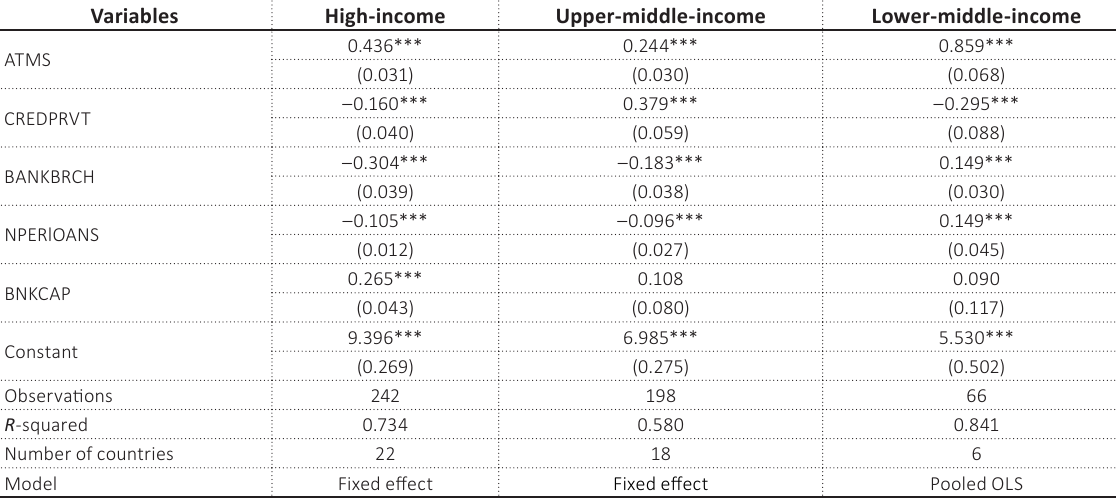
Table 3. Regression